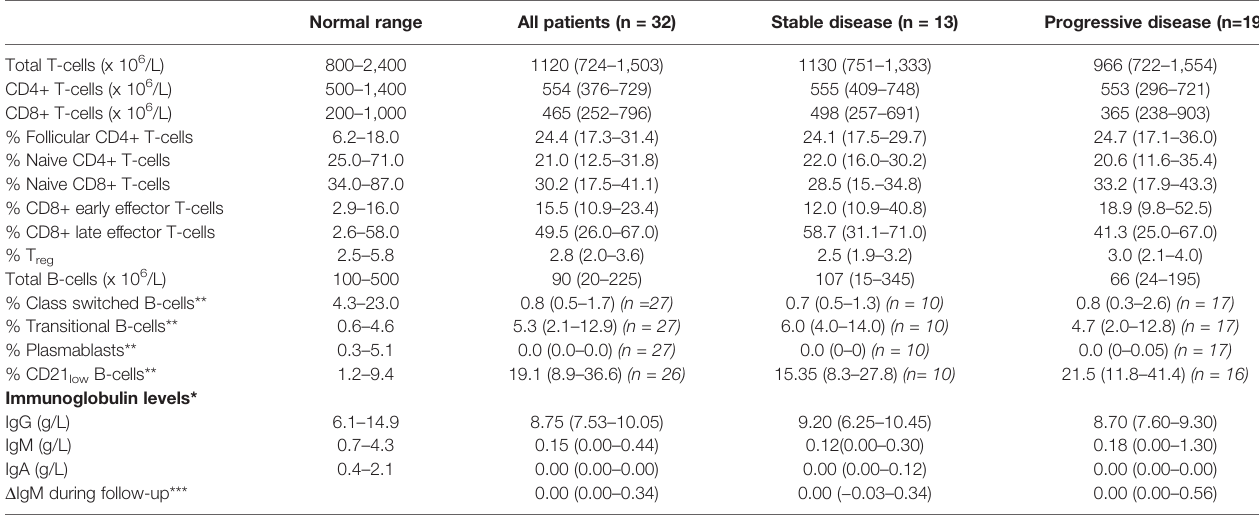
TABLE 2 | Laboratory data. T- and B-cells with subpopulations* Normal range All patients (n = 32) Stable disease (n = 13) Progressive disease